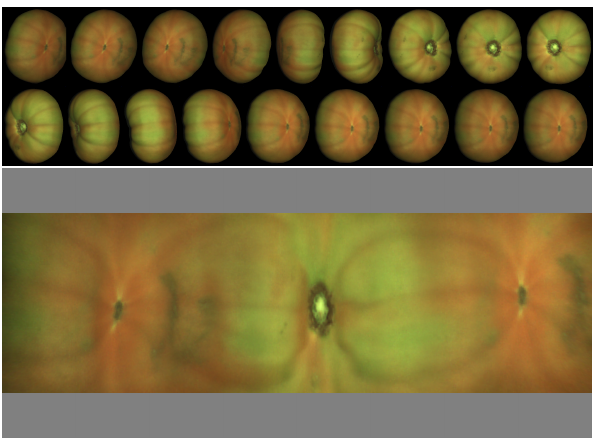
Figure 8. Example of oblate tomato.